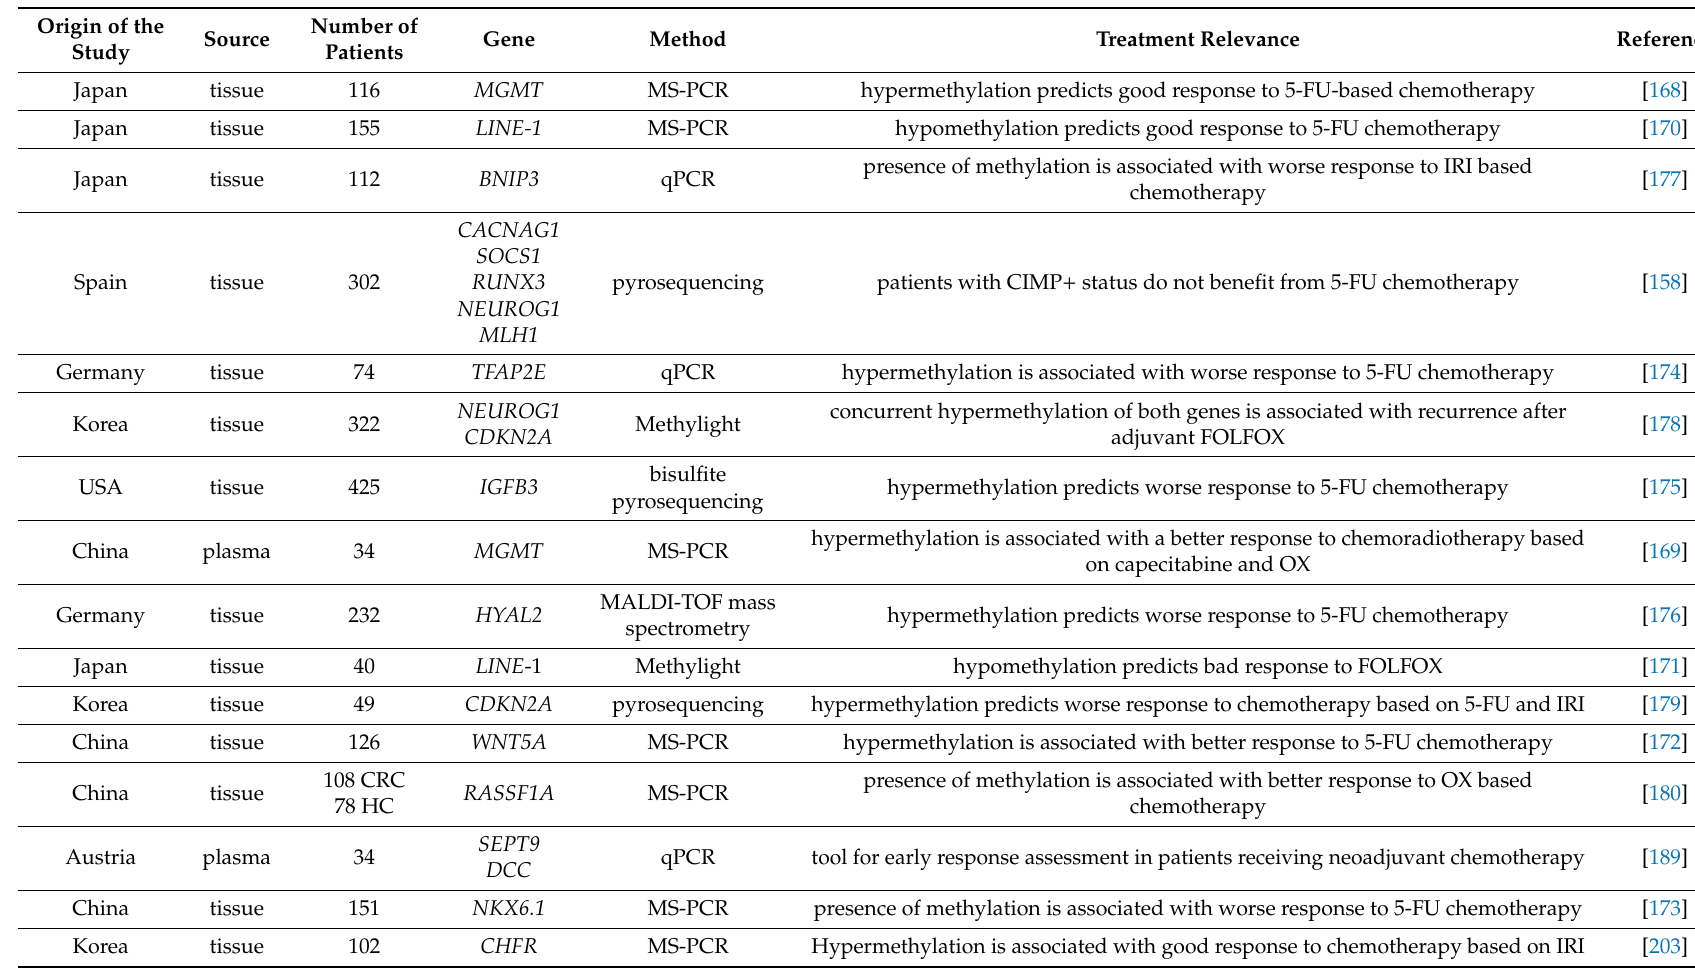
Table 2. Summary of studies focusing on the predictive potential of methylation